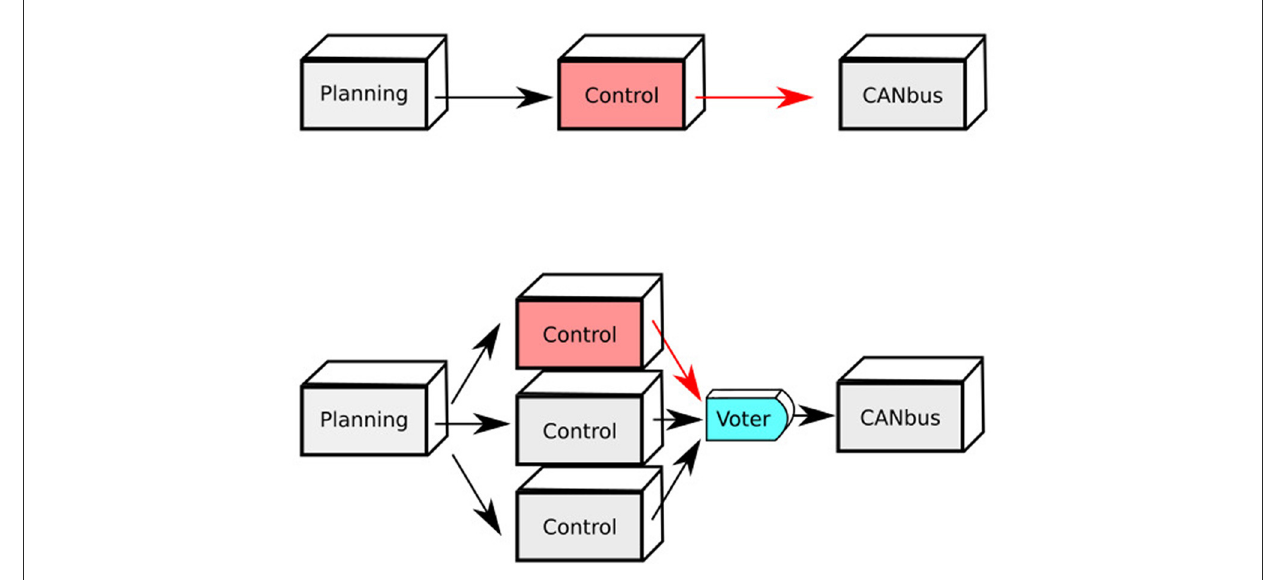
FIGURE2 Triple control module replication with voter module.